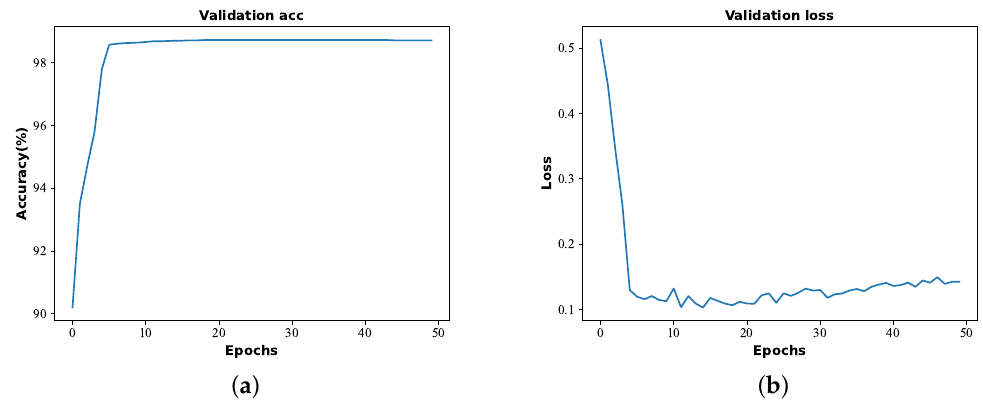
Figure 10. Data for each epoch. Accuracy and loss for each epoch on the validation set. ( a ) Validation accuracy. ( b ) Validation loss.